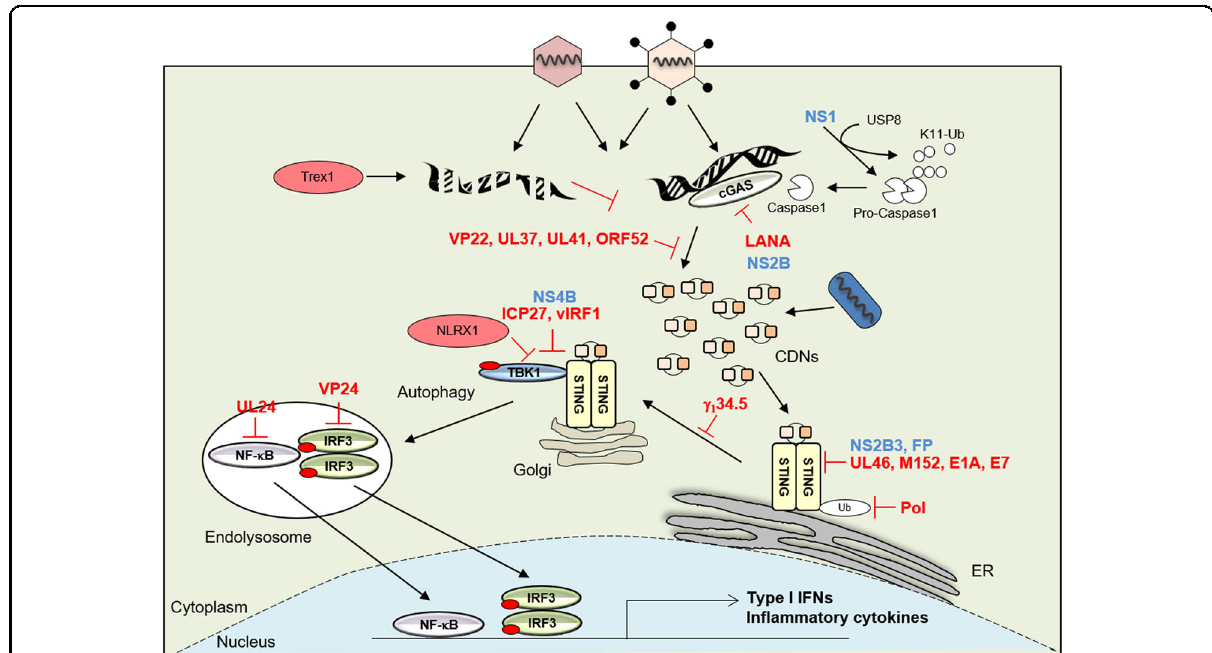
Fig. 1 Activation of STING signaling and viral evasion. STING is activated by cyclic dinucleotides (CDNs) secreted by intracellular bacteria or non- canonical CDNs generated by cGAS. The sensing and interaction of CDNs in fl uences a conformational change in STING and triggers the traf fi cking of STING complexed with TBK1 from the ER to endosomal/lysosomal perinuclear regions. Translocated TBK1 leads to the phosphorylation of IRF3 and NF-kB to induce type I IFNs or in fl ammatory cytokines. Microbial DNA or RNA interacts with cGAS/STING to evade critical innate immune signaling. Red letters: DNA virus proteins, blue letters: RNA virus